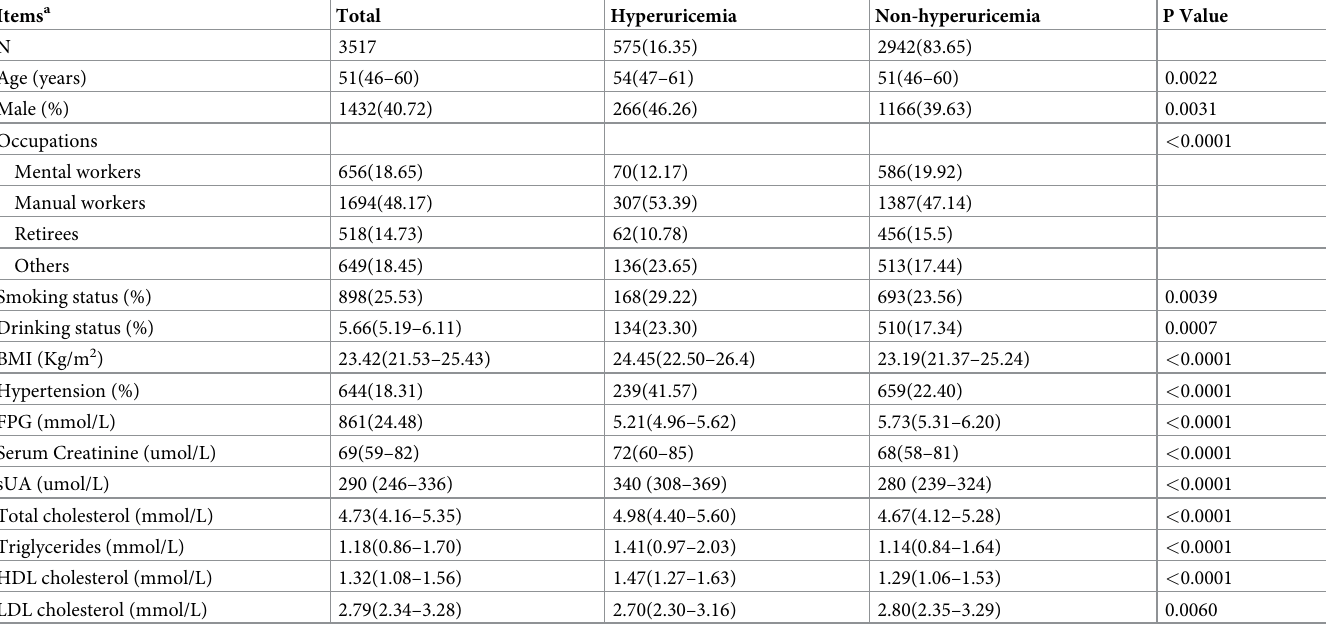
Table 2. Characteristics of the study population with and without hyperuricemia during